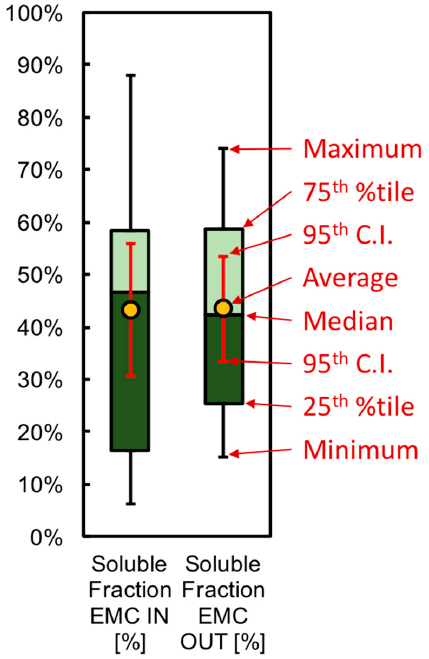
Figure 7. Soluble phosphorus fraction = phosphate/total concentration of rainfall event sample data for n = 18 influent (IN) and effluent (OUT) events in 2016. Note: %tile = percentile and 95th C.I. = 95% confidence interval.